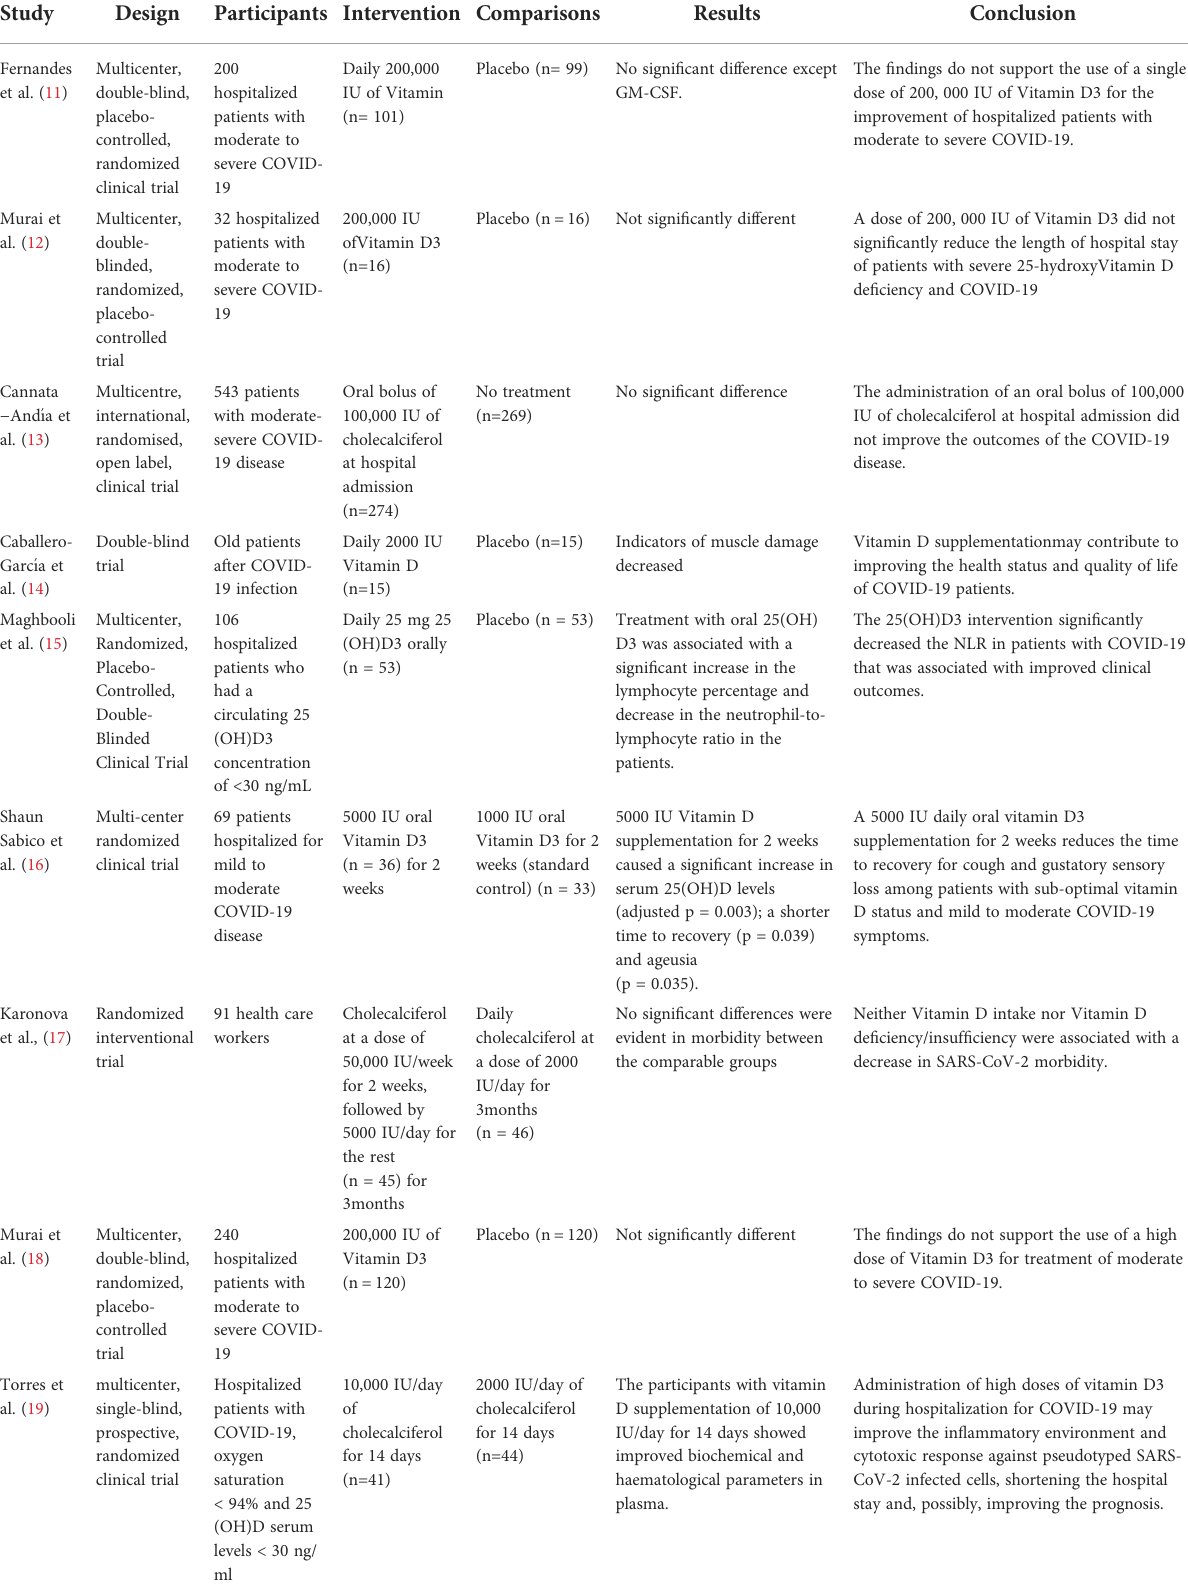
TABLE 2 Summary information on randomized controlled